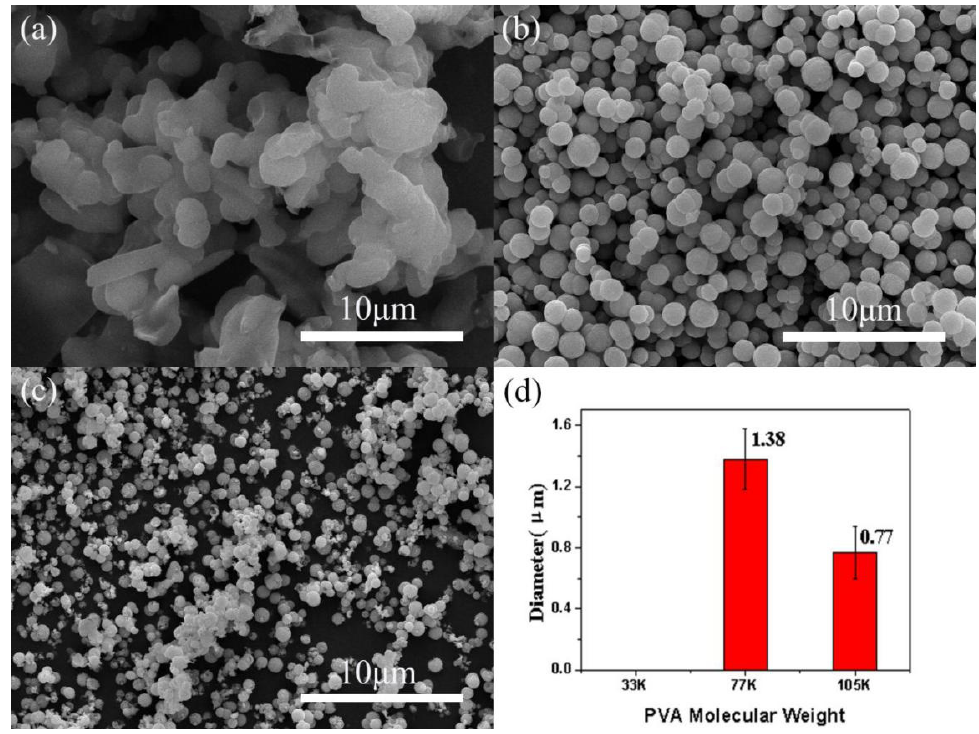
Figure 6. SEM images of the microcapsules (MOCs) synthesized using polyvinyl alcohol (PVA) with a molecular weight of ( a ) 31 K, ( b ) 77 K, and ( c ) 105 K; ( d ) mean diameters obtained using PVA with different molecular weights.